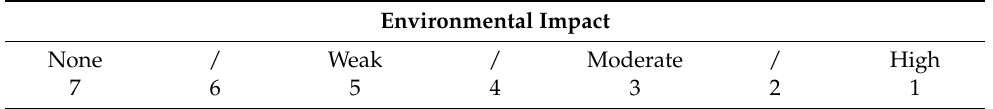
Table 8. Assessment of environmental